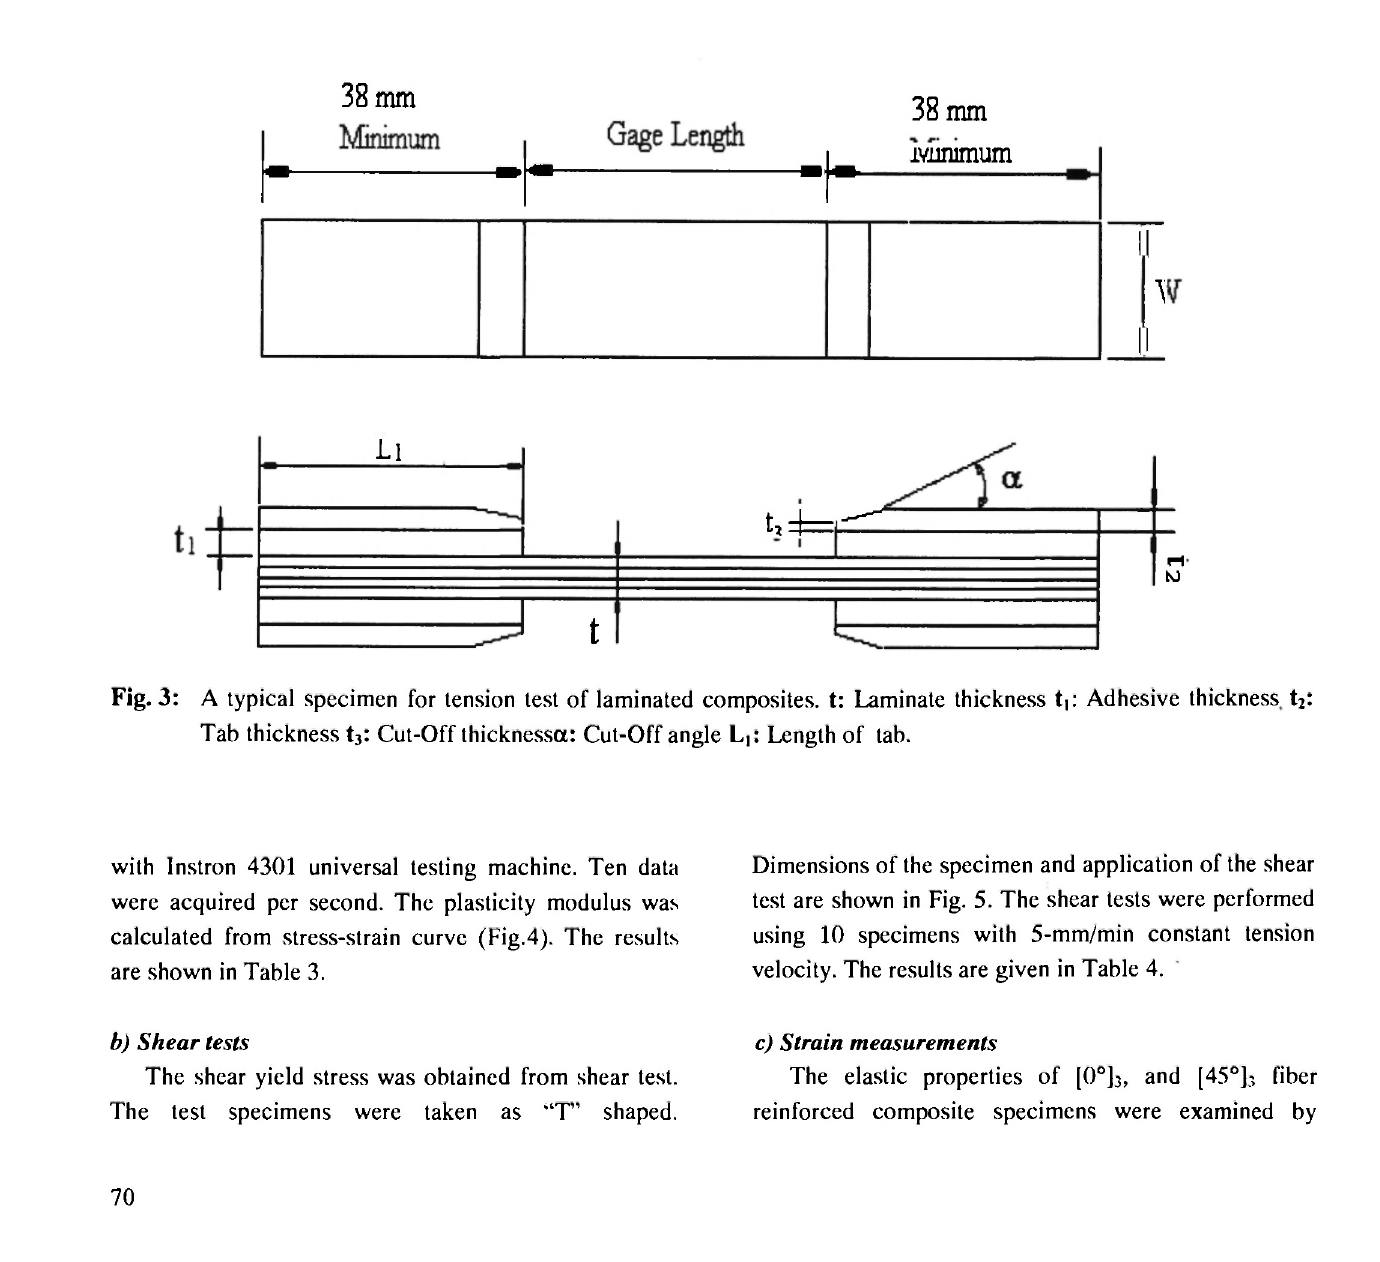
Fig. 2: Dimensions for test specimen, which were carried out experimental elastic-plastic strains